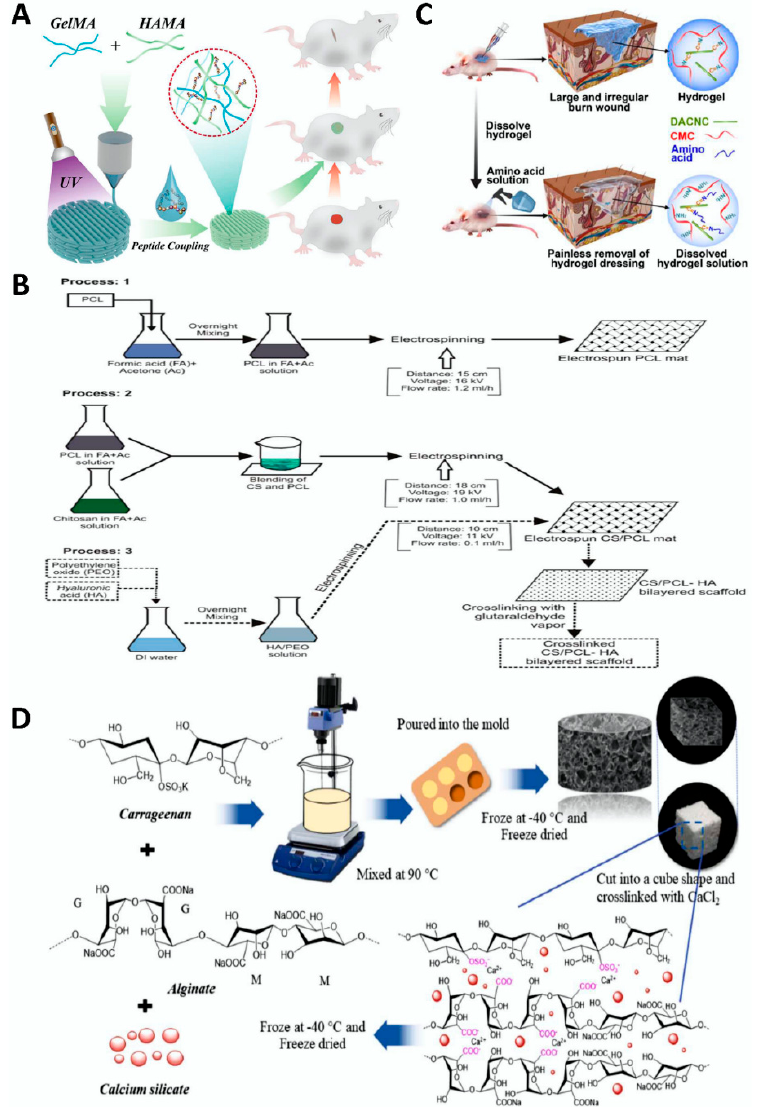
Figure 7. Schematic diagram of the synthesis and tissue engineering application of polysaccharide processed materials. ( A ) schematic diagram of the preparation process of a GelMA/HAMA peptide-coupled patch [106]. ( B ) schematic diagram of the preparation of a CS-PCL-HA double scaffold [107]. ( C ) synthesis and application diagram of hydrogels prepared from DACNC and CMC as materials [108]. ( D ) schematic diagram of preparation of alginate, carrageenan, and calcium silicate composite scaffolds [109].